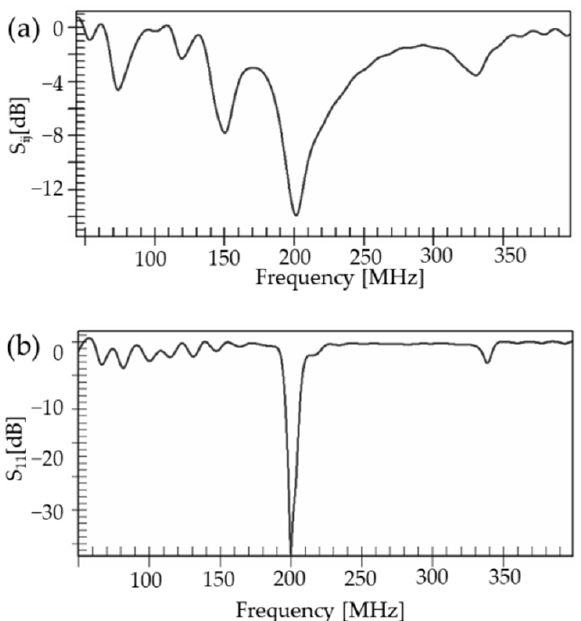
Figure 2. The S-parameters of the tuned coils while loaded with the human model ( a ) head BC coil ( b ) yurt BC coil.